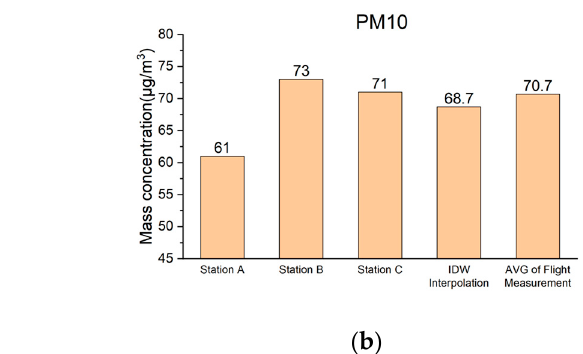
( c ) Figure 17. Comparison of PM concentration at measurement point before and after operation of harvester started working: ( a ) PM2.5; ( b ) PM10; ( c ) TSP. From the experimental results, it can be seen that before the harvester started work- ing, the concentration of three types of PM followed a unimodal pattern, starting from the minimum concentration at ground level, reaching the maximum at 30 m or 20 m, and then fluctuating and slowly declining with increasing altitude. The concentration of TSP de- creased faster than the other two kinds of particles [29,30], which may be because the par- ticles of 10~100 μ m settle faster due to their larger mass [31,32]. After the harvester started working for a period of time, the concentrations of three types of PM all increased signif- icantly, and their changing trends with increasing altitude were also different from those 0 10 20 30 40 50 60 70 80010203040 5060